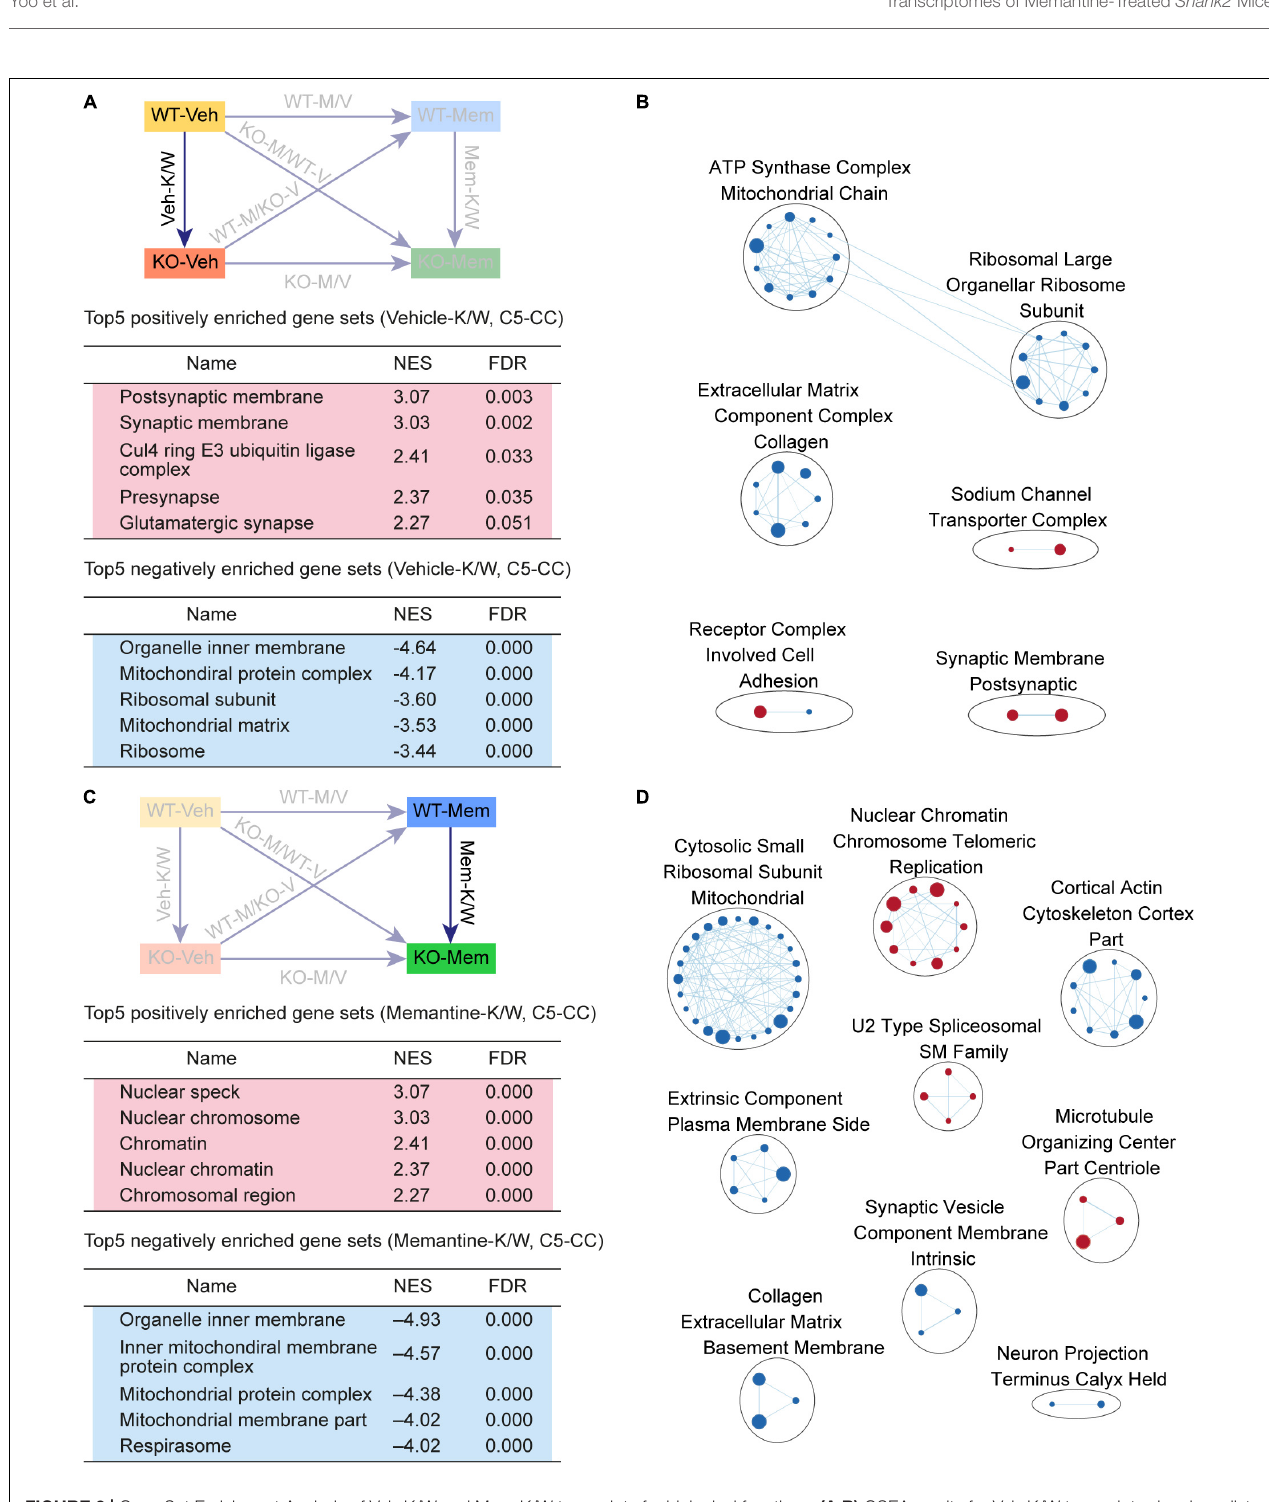
FIGURE 3 | Gene Set Enrichment Analysis of Veh-K/W and Mem-K/W transcripts for biological functions. (A,B) GSEA results for Veh-K/W transcripts showing a list of the top five positively (red) and negatively (blue) enriched gene sets (A) and their integrated visualization, generated using the Cytoscape App, EnrichmentMap (B) . Only the results for C5-CC are shown here; those for C5-BP and C5-MF are shown in Supplementary Figure 1 . Note that only the top five gene sets are shown in the main figure tables for simplicity (see the full lists in Supplementary Tables ). All GSEA results were visualized using EnrichmentMap. Each circle in a cluster indicates significantly (FDR < 0.05) enriched individual gene sets with the size and color (red/blue) of the circles indicating gene-set size and positive/negative enrichment based on NES scores, respectively. [ n = 3 mice (WT-Veh, KO-Veh), FDR < 0.05]. (C,D) GSEA results for Mem-K/W transcripts showing a list of the top five positively (red) and negatively (blue) enriched gene sets (C) and their integrated visualization generated using the EnrichmentMap Cytoscape App (D) . See Supplementary Figure 2 for GSEA C5-BP/MF results. [ n = 3 mice (WT-Mem, KO-Mem), FDR < 0.05].